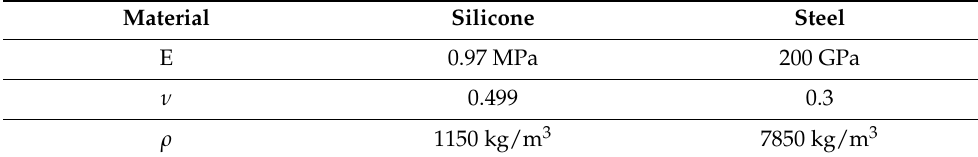
Table 1. Materials’ properties.